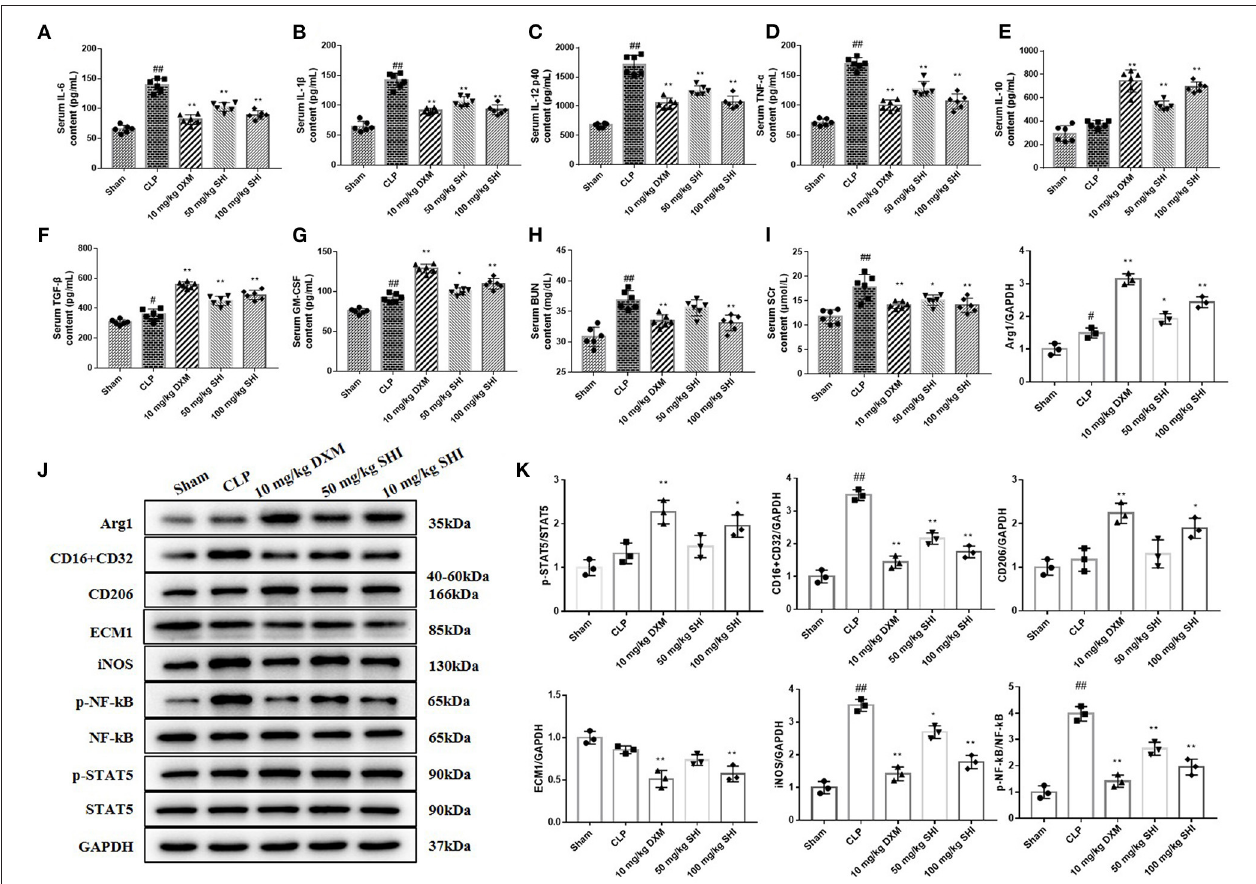
FIGURE 2 | Improvement of serum and kidney biochemical parameters by Shionone in sepsis-induced acute kidney injury rats. (A–G) ELISA for the detection of inflammatory factors (IL-6, IL-1 β , IL-12, TNF- α , IL-10, TGF- β , and GM-CSF) in the serum of sham and kidney injury groups ( n = 6). (H,I) The contents of BUN and Scr in rats’ serum in sham and kidney injury groups ( n = 6). (J) Western blot analyses of renal expressions of Arg1, CD16 + CD32, CD26, ECM1, iNOS, p-NF- κ B, NF- κ B, p-STAT5, and STAT5 in sham control and injured kidneys groups. (K) Relative expression analysis of Arg1, CD16 + CD32, CD26, ECM1, iNOS, p-NF- κ B, NF- κ B, p-STAT5, and STAT5 ( n = 3). Sham group was used as a negative control and CLP group as a positive control. Results are expressed as ± SD for independent experiments, # p < 0.05 vs. Sham group, ## p < 0.01 vs. Sham group, and * p < 0.05 vs. CLP group, ** p < 0.01 vs. CLP group, one ANOVA followed by Tukey’s post-hoc